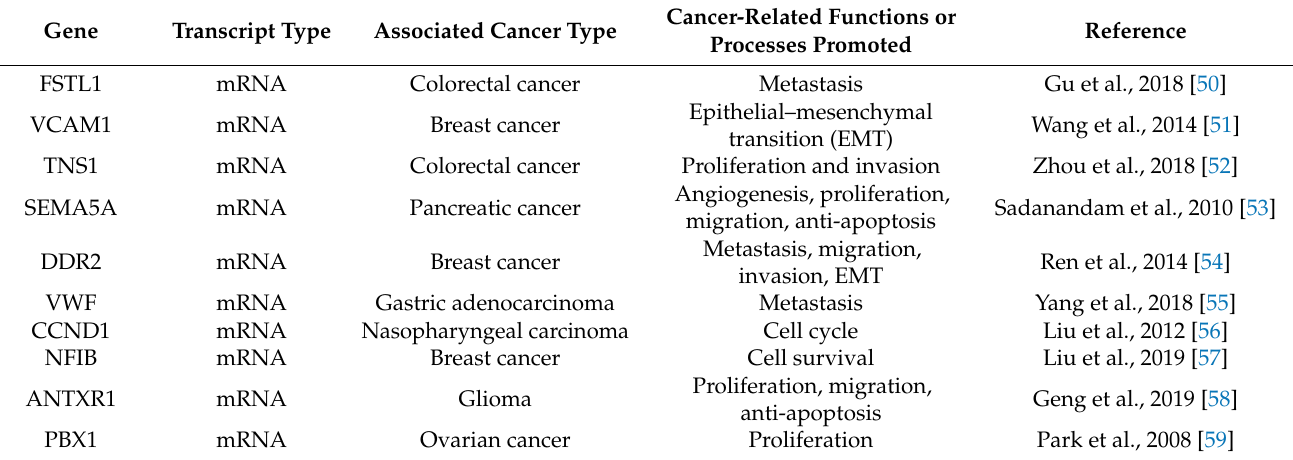
Figure 5. The transcript levels of top 10 cancerogenesis-associated protein-coding genes. Box-and- whisker plots of the 10 cancerogenesis-associated mRNAs that are most significantly overexpressed in 32 MCL samples compared with the 5 B-cell subtype samples are shown in the statistical significance order ( A – J ). Table 1. The list of the top 10 overexpressed oncogene-candidate protein-coding transcripts in MCL